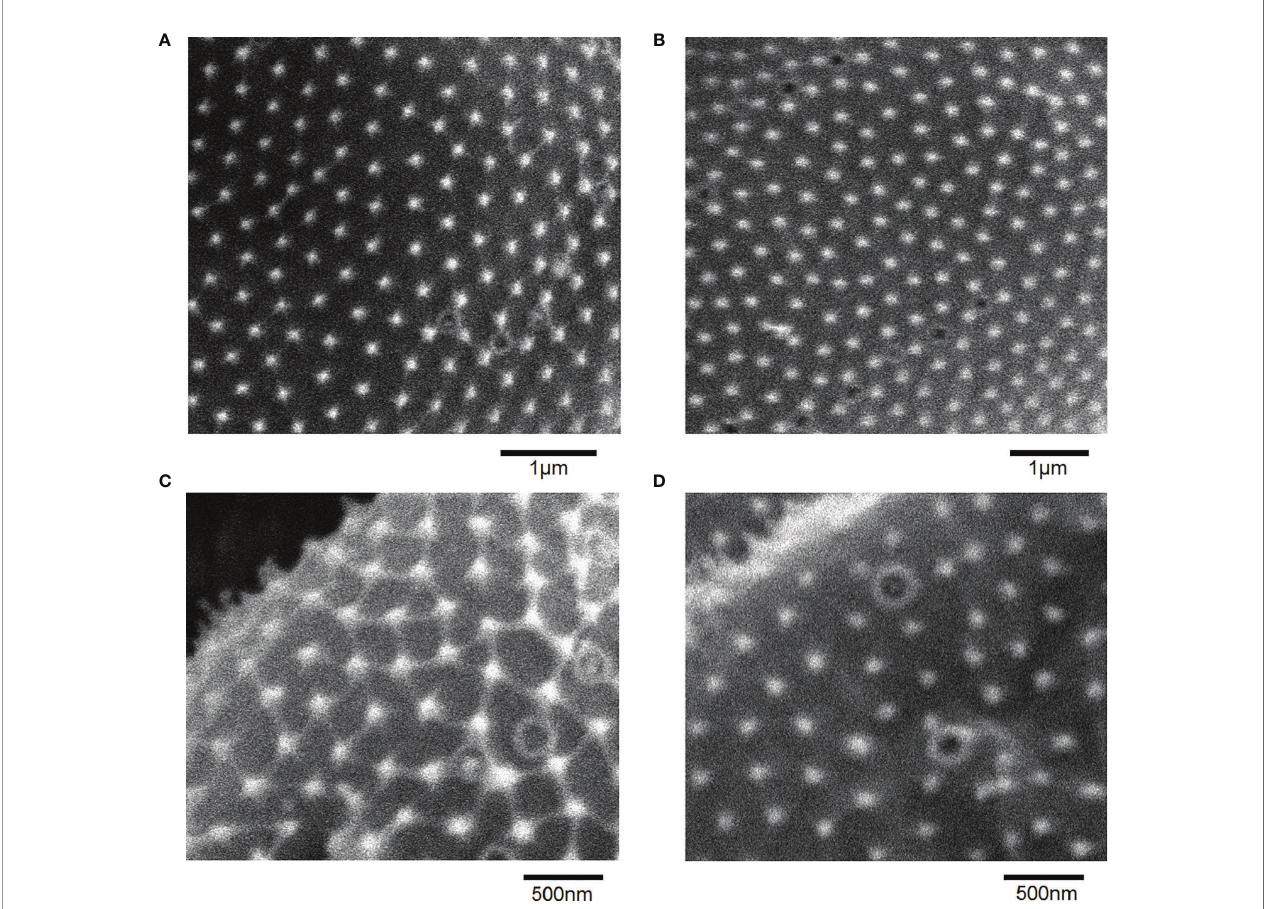
FIGURE 3 | Morphology of P. donghaiense by SEM. (A, C) The normal culture conditions. (B, D) The nitrogen limiting